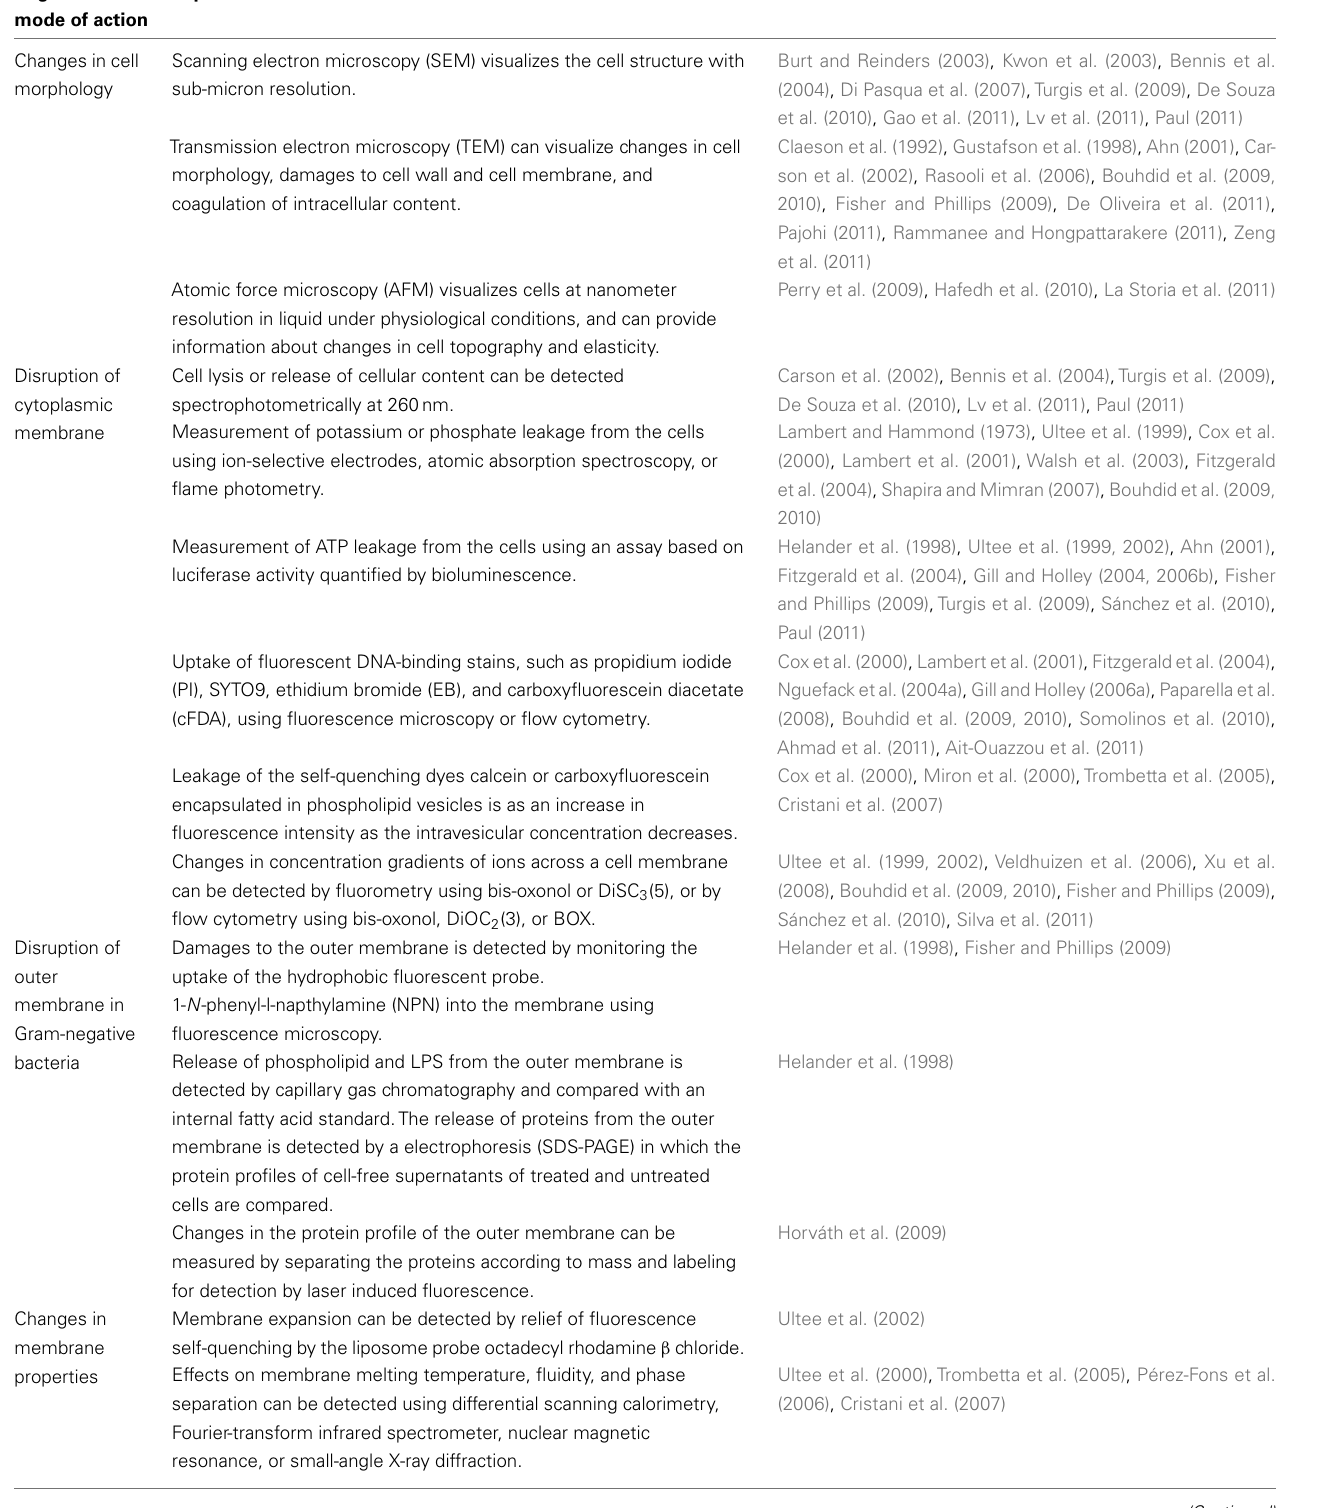
Table 3 | Overview of experimental approaches used to identify target sites and modes of action of antimicrobial compounds. Target site